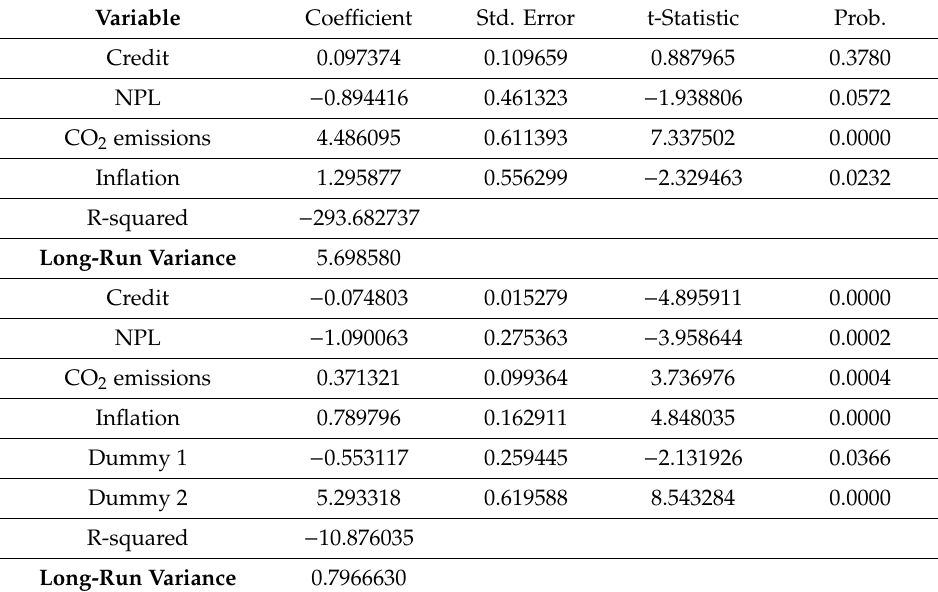
Table 12. Panel Fully Modified Ordinary Least Squares